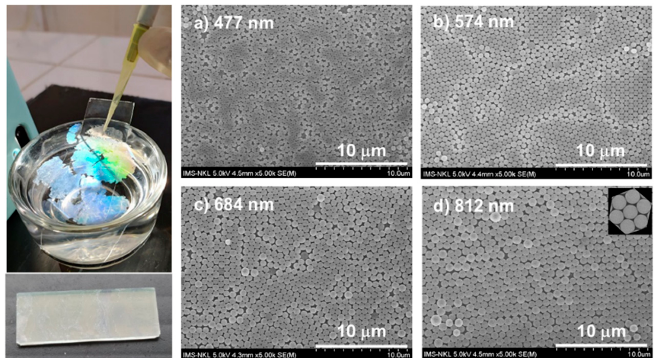
Figure 1. Trapping a monolayer of polystyrene (PS) sub-microspheres on the water/air interface (left panel), and SEM images of the close-packed monolayers of PS beads with diameters of ( a ) 477 nm, ( b ) 574 nm, ( c ) 684 nm, and ( d ) 812 nm after transferring them onto substrates.